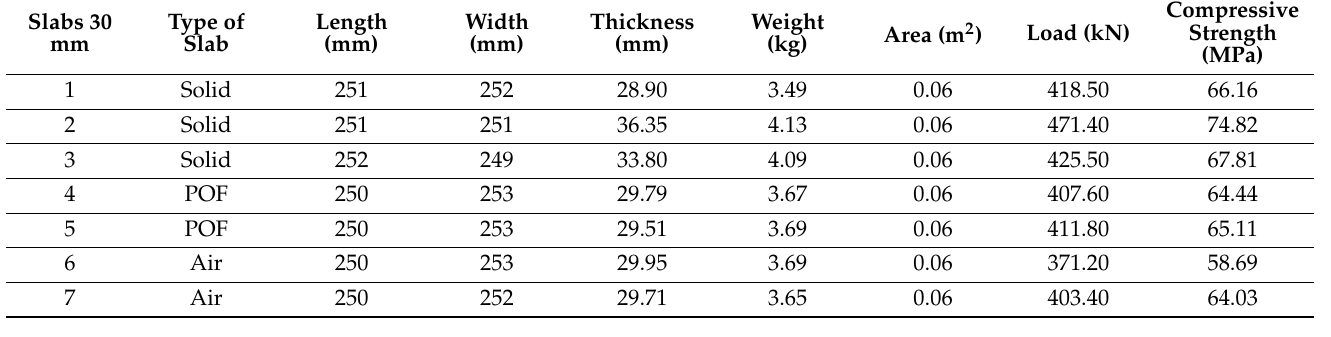
Table 12. Properties of slabs 30 mm thick for measuring compressive strength.